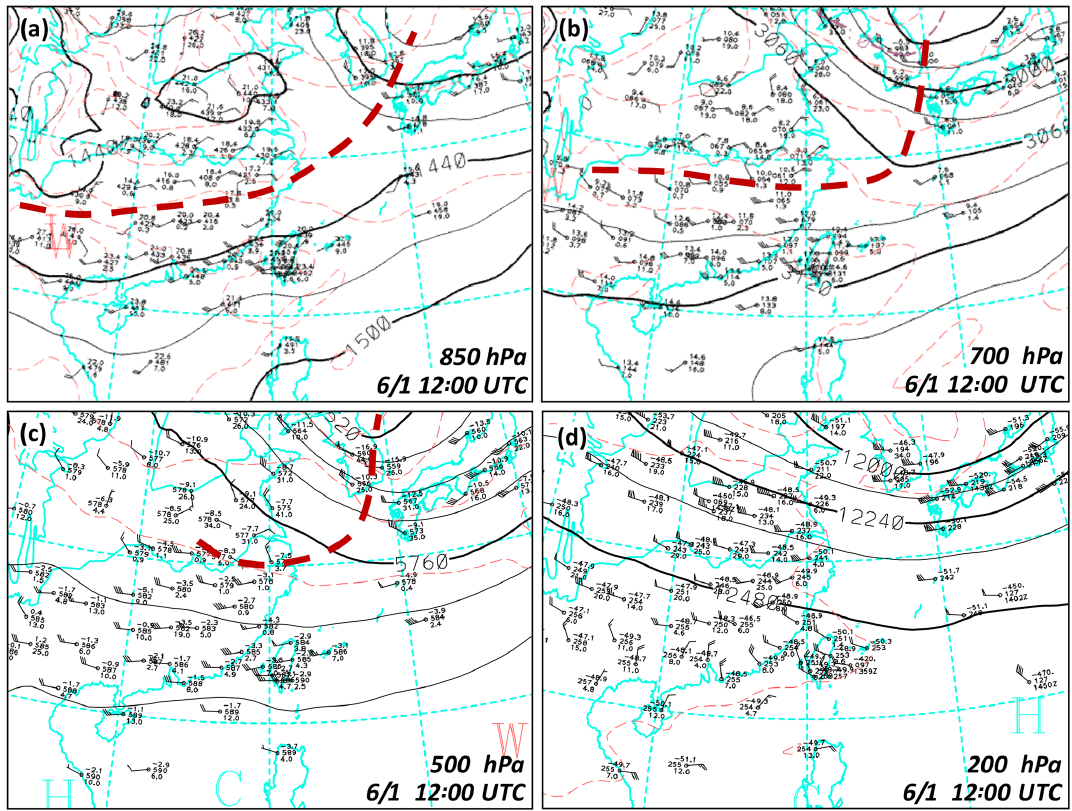
Figure 3. The CWB upper-air charts surrounding Taiwan at (a) 850, (b) 700, (c) 500, and (d) 200hPa at 12:00UTC on 1 June 2017. In the panels, geopotential height (gpm, solid isopleths) and temperature ( ◦ C, thin red dashed isotherms) are analyzed at intervals of 30, 30, 60, and 120gpm and 3, 3, 5, and 5 ◦ C, respectively, following the order (source: CWB). The thick red dashed lines mark troughs or wind-shift